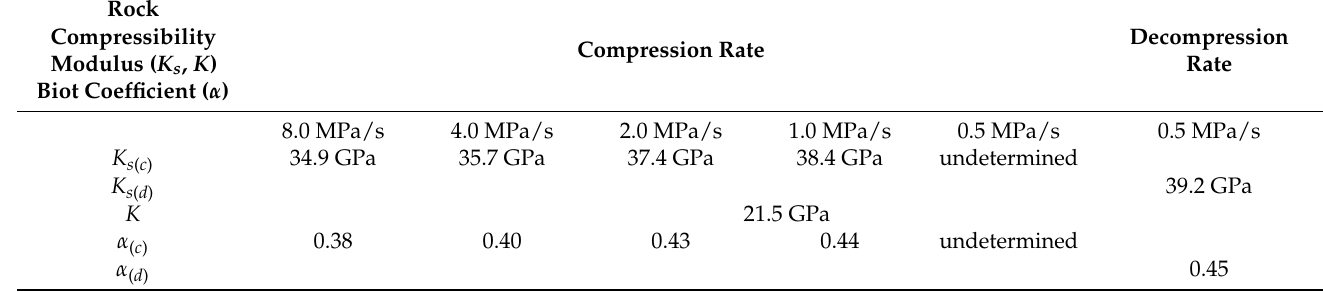
Table 5. Volumetric moduli of compressibility and Biot’s coefficients for compression ( K s ( c ) , α ( c ) ) and decompression ( K s ( d ) , α ( d ) ); FU test, Tumlin